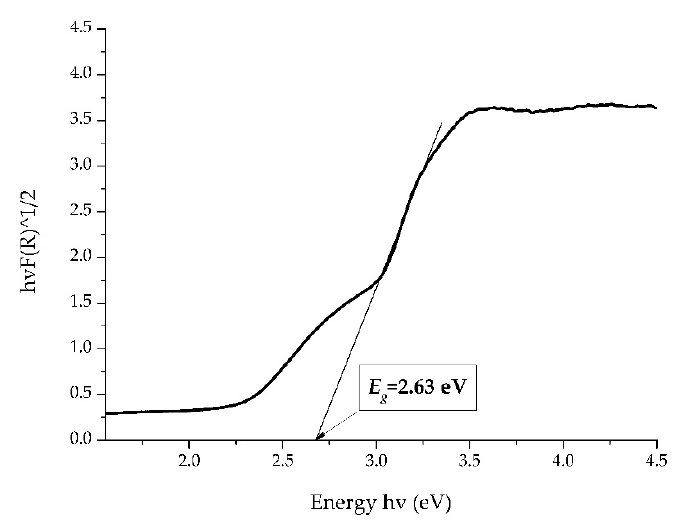
Figure 4. Reflection F(R) to wavelength (nm) graph for N-doped TiO 2 powder.